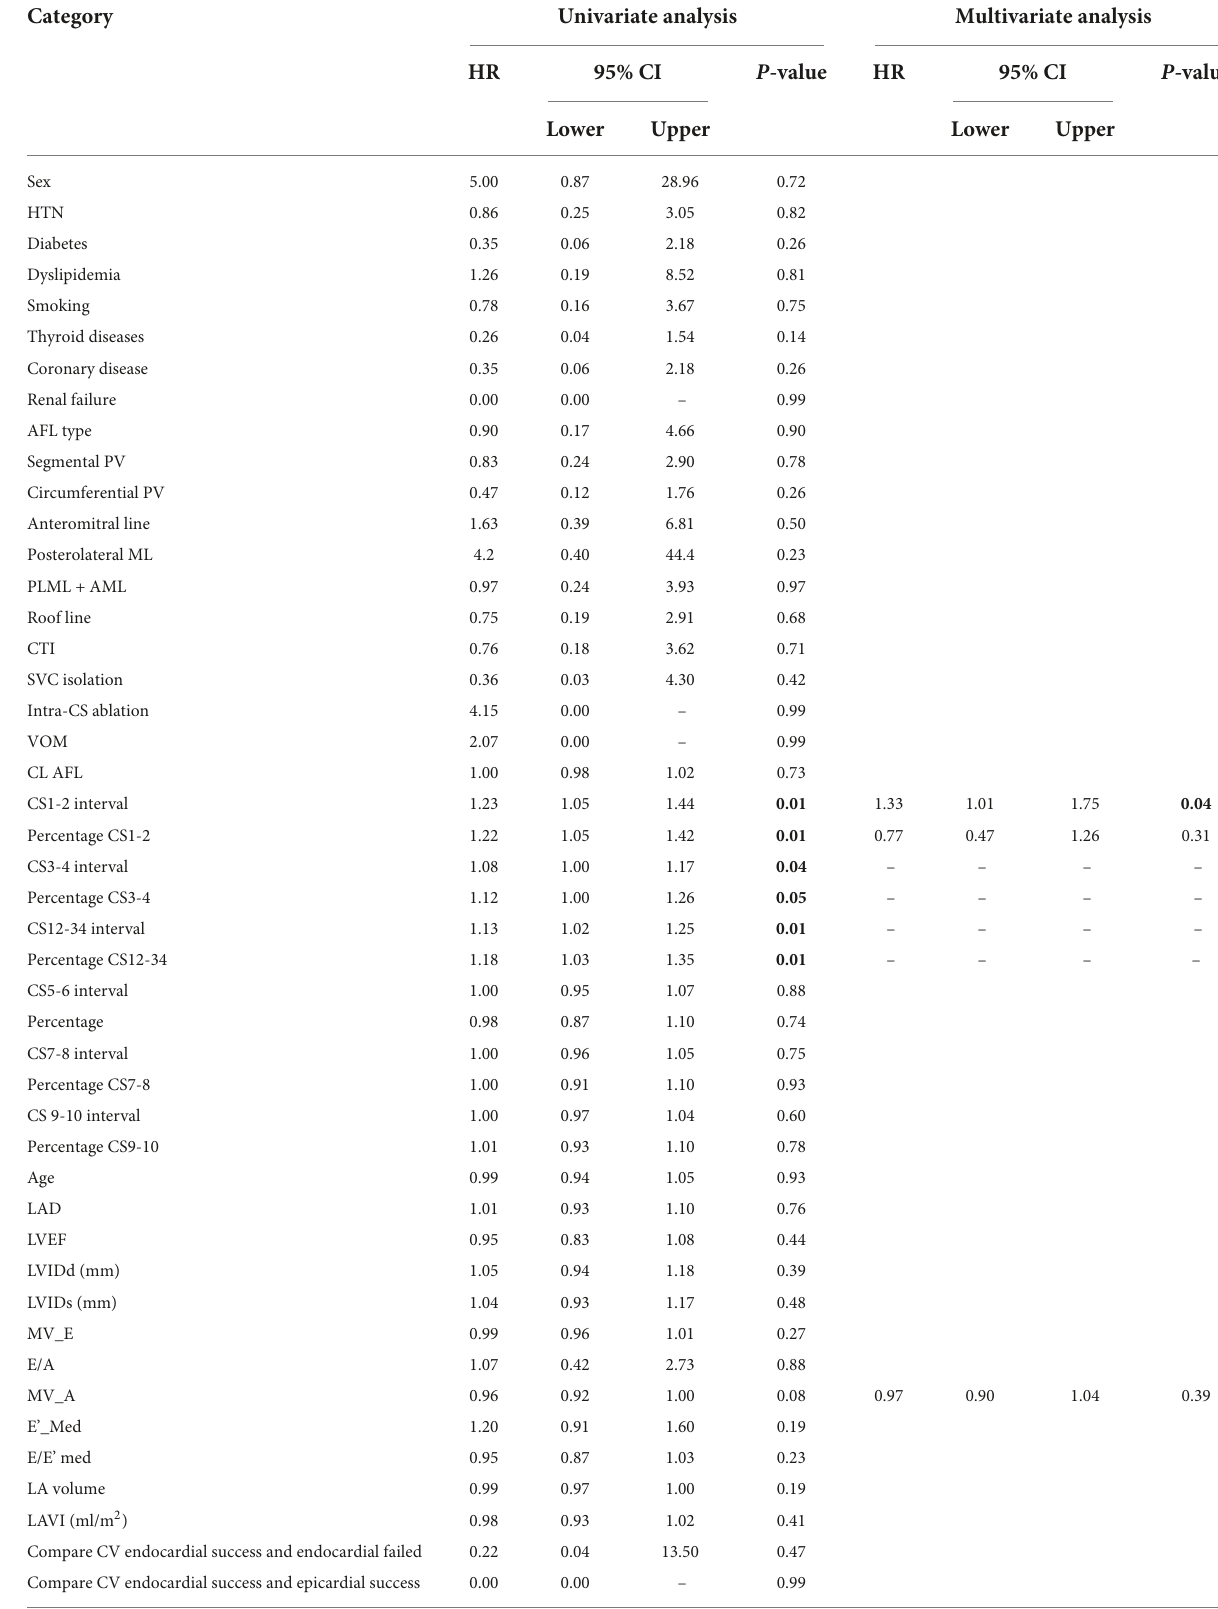
TABLE 3 Multivariate